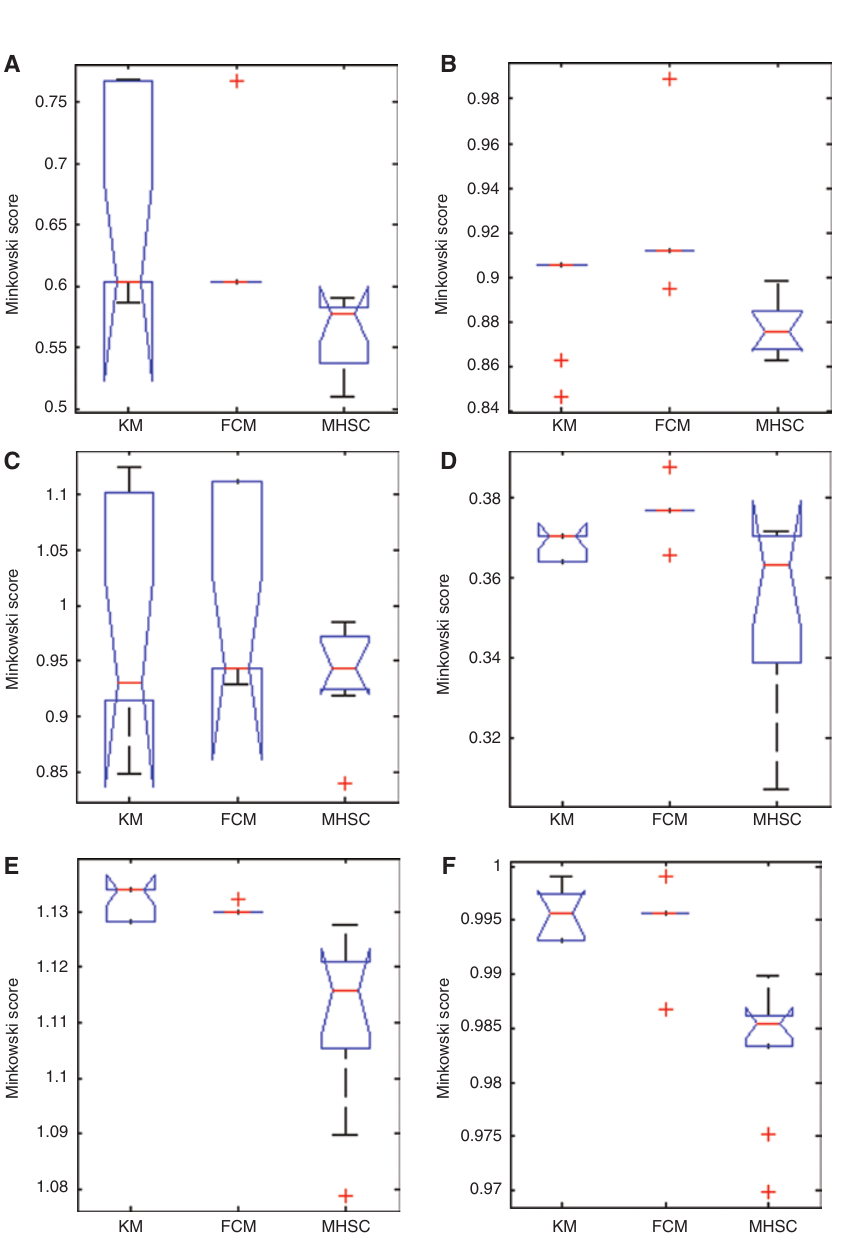
Figure 8: Boxplots of the Minkowski scores obtained by the clustering techniques for datasets (A) Iris, (B) Wine, (C) Glass, (D) Cancer, (E) CMC, and (F)